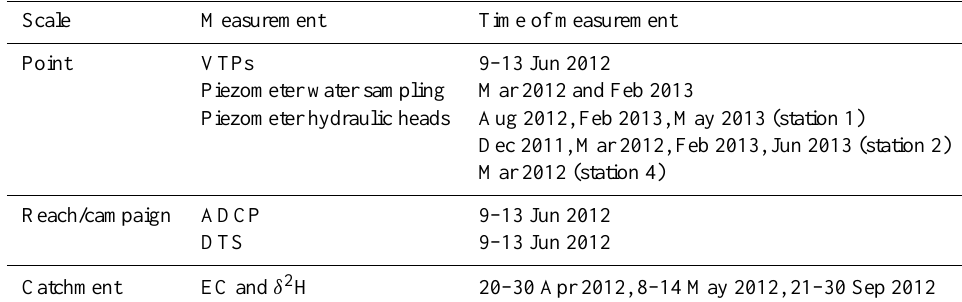
Table 2. Summary of sampling periods and data collection methods, with the scale covered by the method, the method/instrument and time of measurement.